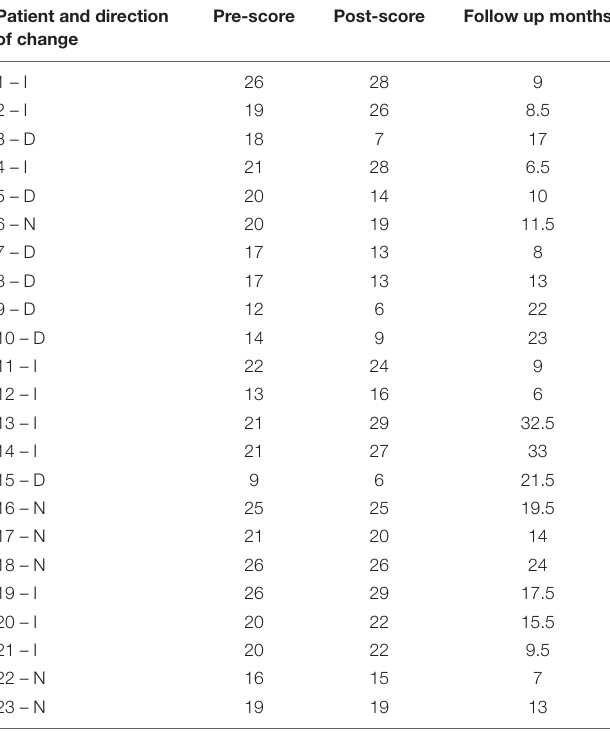
TABLE 4 | Changes in cognition scores for series of 23 patients from one office. Patient and direction of